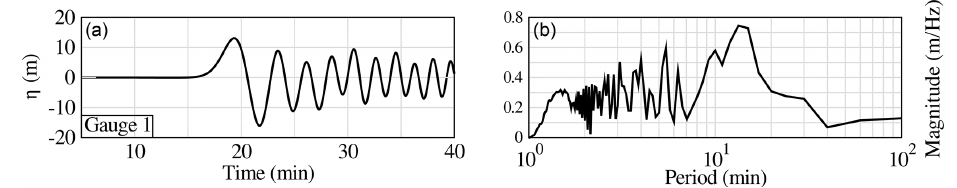
Figure 15. Surface elevation (m; a ) and associated Fourier transform (b) for the 80km 3 scenario at Gauge 1 close to the source. The time takes into account the first 20min of the slide and tsunami generation.